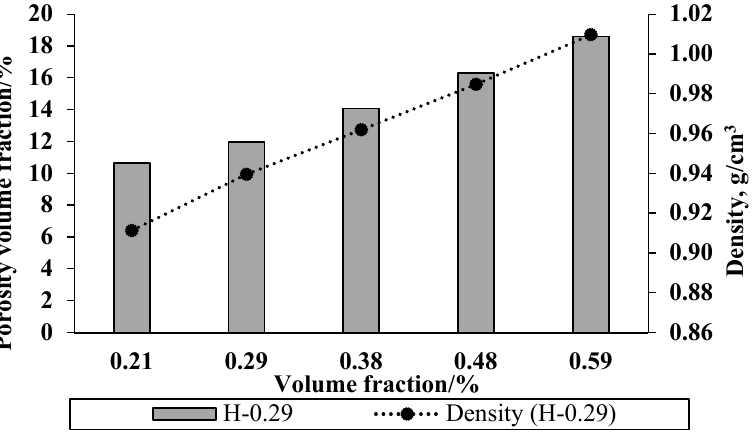
Figure 13. Density and porosity of composites as a function of the volume fraction of fibres.